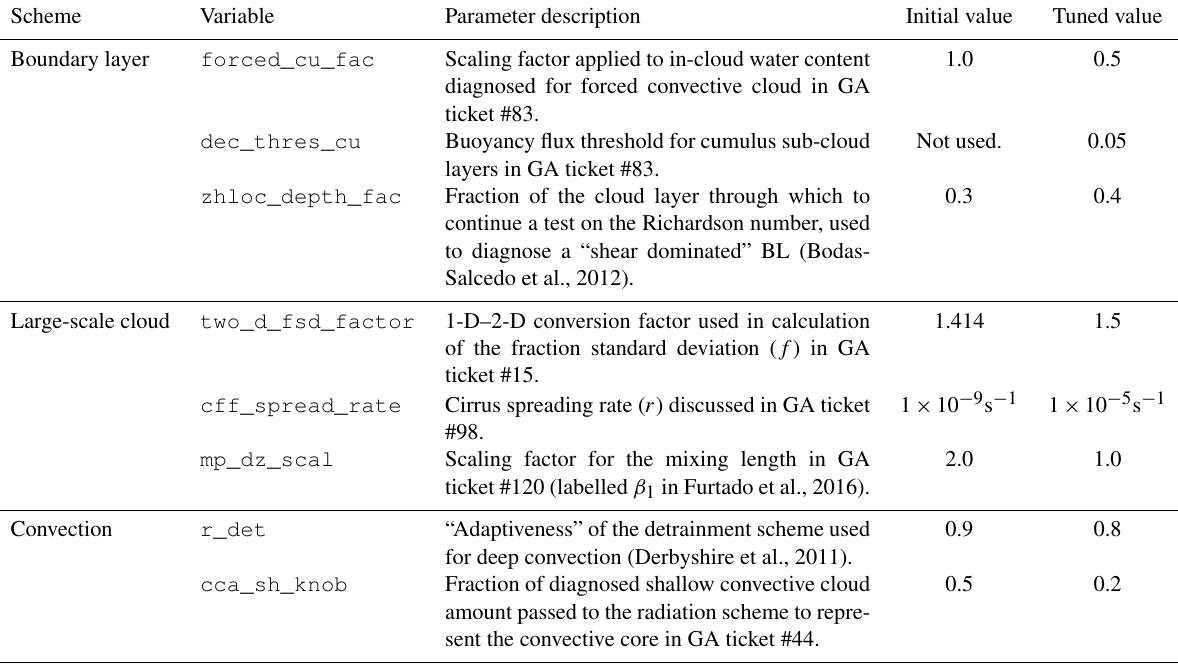
Table 7. Initially proposed and final values of parameters tuned to improve cloud and radiation interactions in GA7.0.